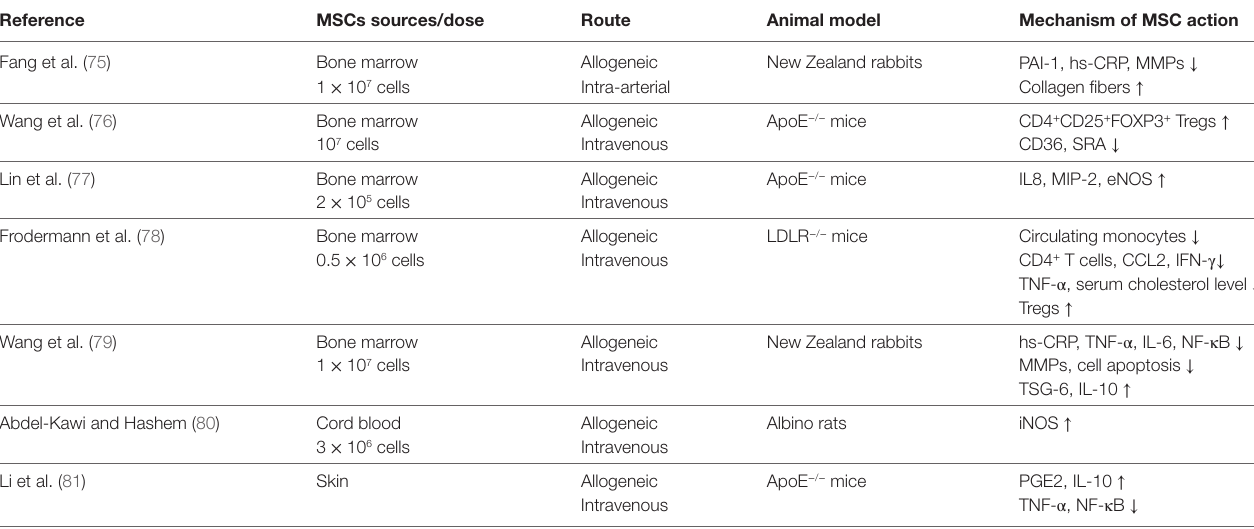
TAbLe 1 | Mesenchymal stem cell (MSC) treatments against atherosclerosis in animal